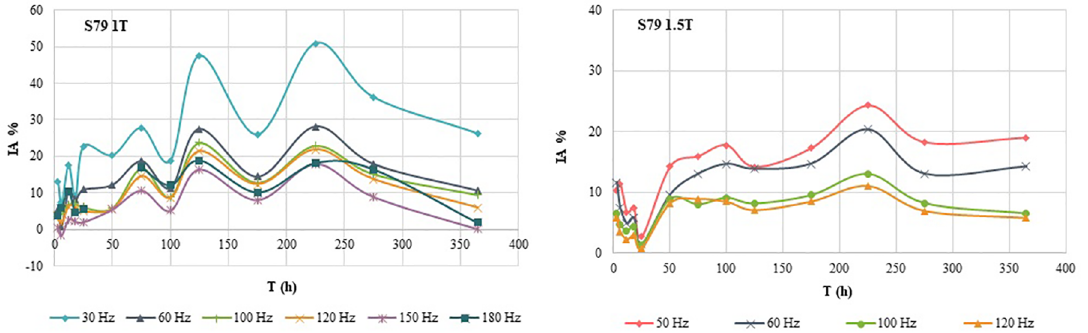
Figure 7. Anomalous losses from different aging time against the excitation frequency, for steel